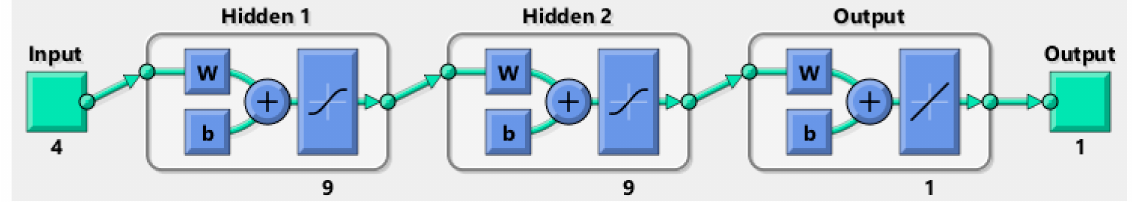
Figure 13. Architecture of the ANN model as represented in